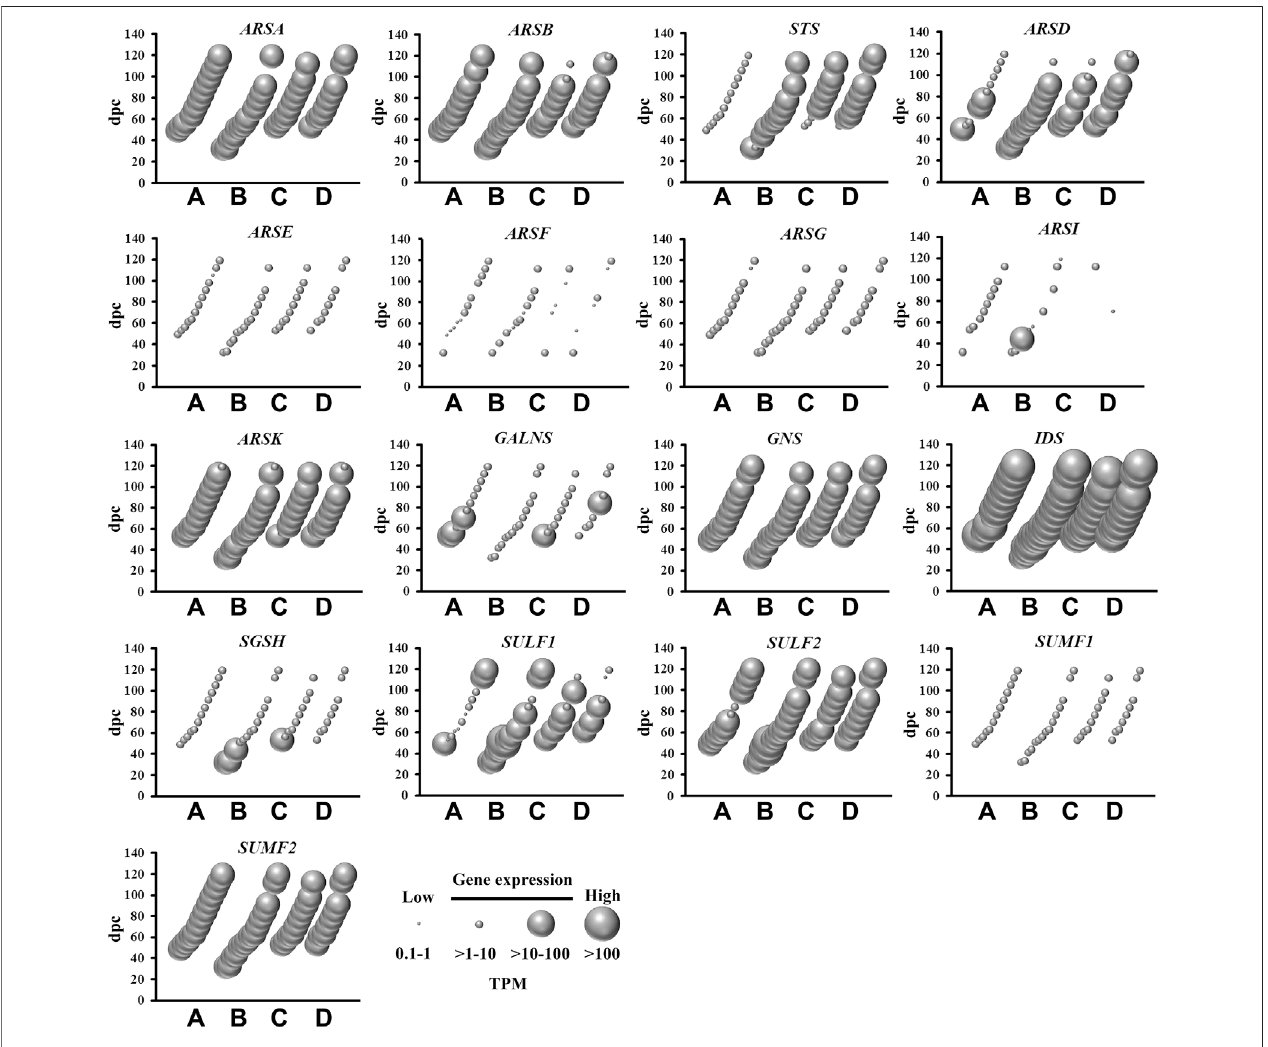
FIGURE 4 | Spatial and temporal mRNA expression of sulfatases and sulfatase modifying factors in fetal brain regions (A) cerebrum, (B) brainstem, (C) diencephalon, and (D) cerebellum. dpc, days post-conception. TPM, transcripts per million.